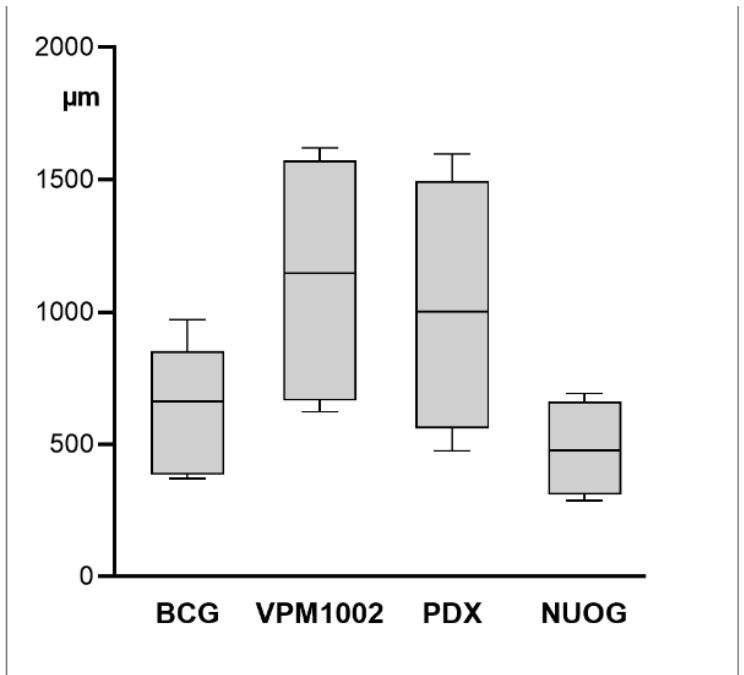
Figure 7. Width of inflammatory cell infiltrate of granulomas in goats after subcutaneous injection of BCG, VPM1002, PDX or NUOG. Width was measured in HE-stained paraffin sections at eight equidistant sites per granuloma. Each column represents measurements from six goats. Interquartile range (grey box), median (line) as well as maximum and minimum width (whiskers) are indicated.